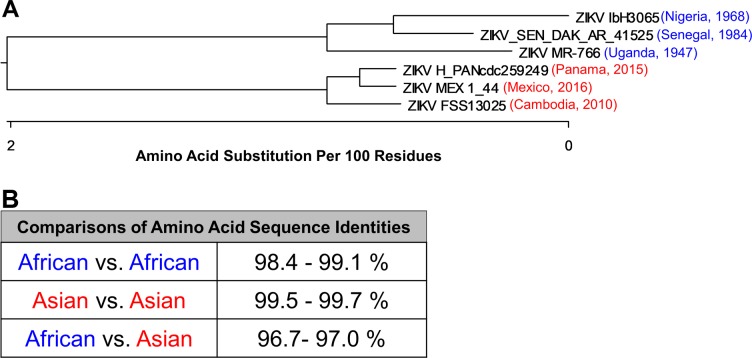
Phylogenetic tree for genetic comparison of the ZIKV strains used in this study.(A) Published amino acid sequences (NCBI GenBank) of the six ZIKV strains were used to construct a phylogenetic tree using the neighbor-joining method. The AS (red) and AF strains (blue) show a clear separation into two distinct clusters based on their amino acid sequences. (B) Comparison of amino acid sequence identities between the six viruses when clustered into the AF and AS lineages.